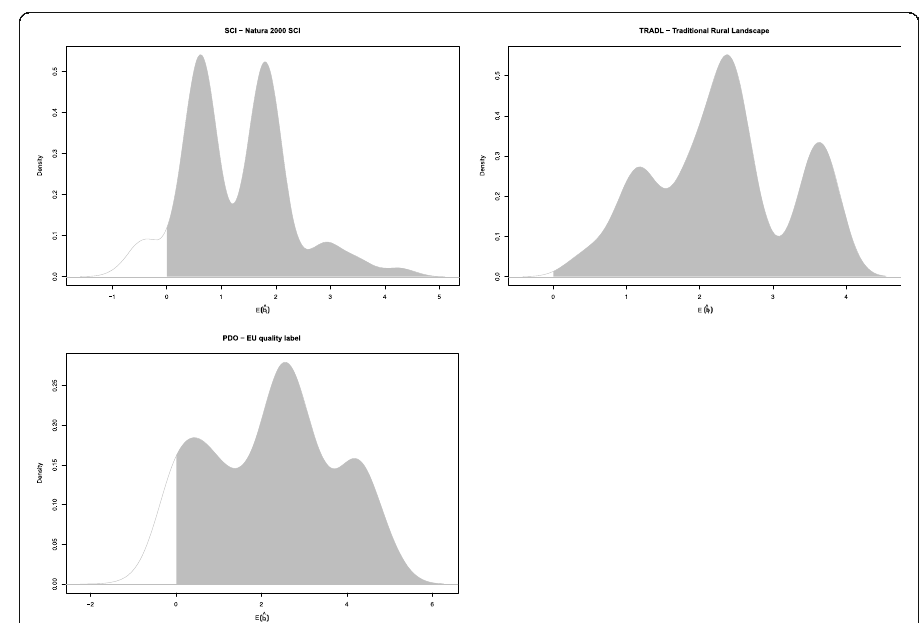
Fig. 2 Kernel density distribution functions of the estimated random parameters (RPL model)